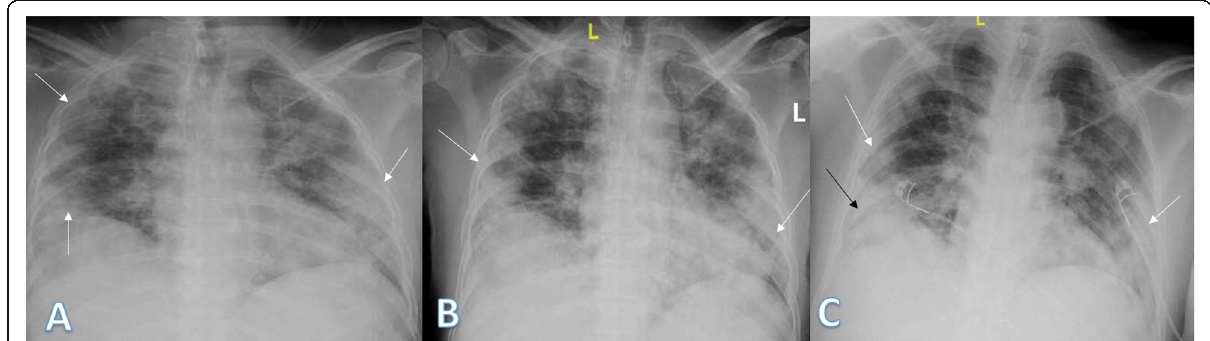
Fig. 16 48-year male with positive COVID-19 virus. Initial chest X-ray ( a ) showed air space consolidation opacities at the periphery of the right lung and the mid and lower zones (arrows) with TSS as 4 (2 for each lung). On the 3rd day ( b ) and 6th day ( c ), air space consolidation opacities (arrows) were almost the same with mild right pleural effusion (black arrow on c